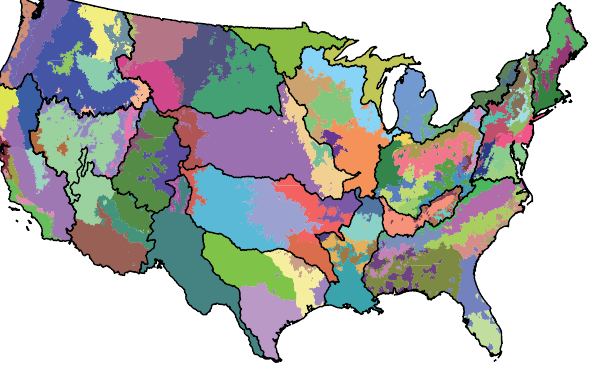
Figure 6. Final 110 monthly water balance model calibration re- gions differentiated by colors. A subset of streamgages within each calibration region were calibrated in a group-wise fashion to pro- duce a single optimized parameter set for the entire region (Fig. 3).